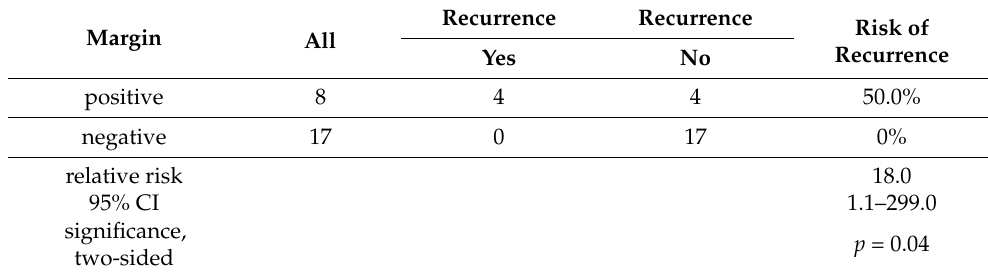
Table 4. Initial margin status informs loco-regional recurrence risk.